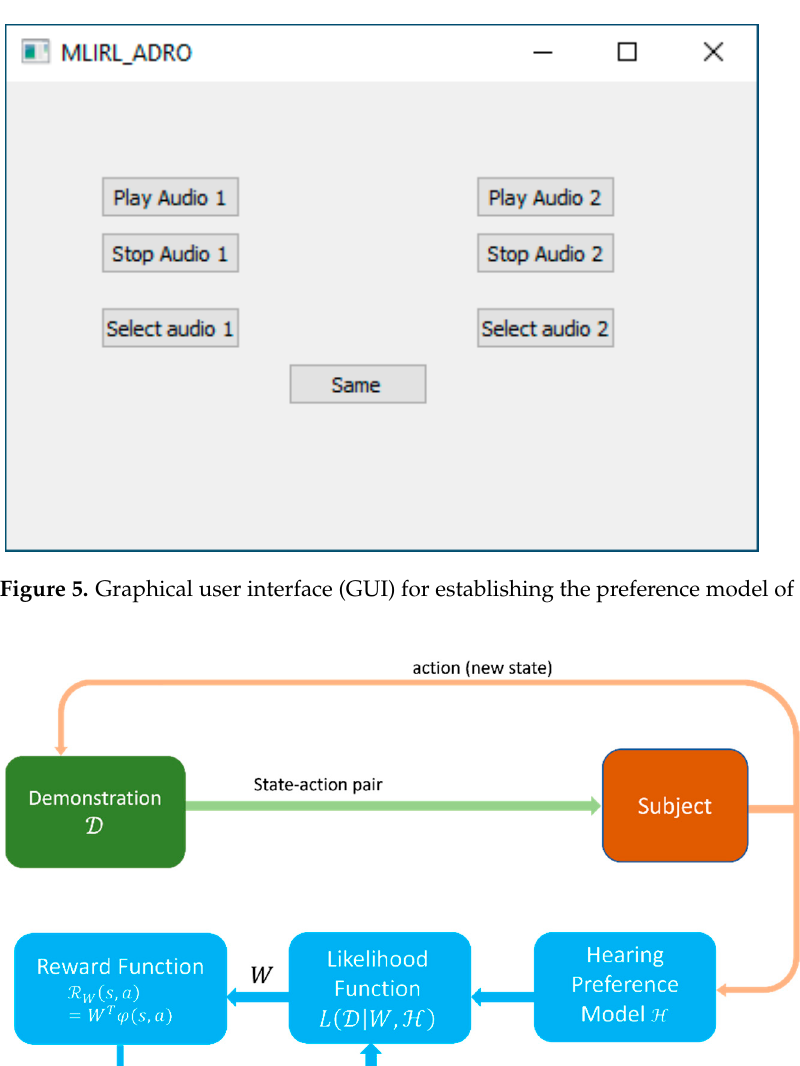
Figure 5. Graphical user interface (GUI) for establishing the preference model of a subject.